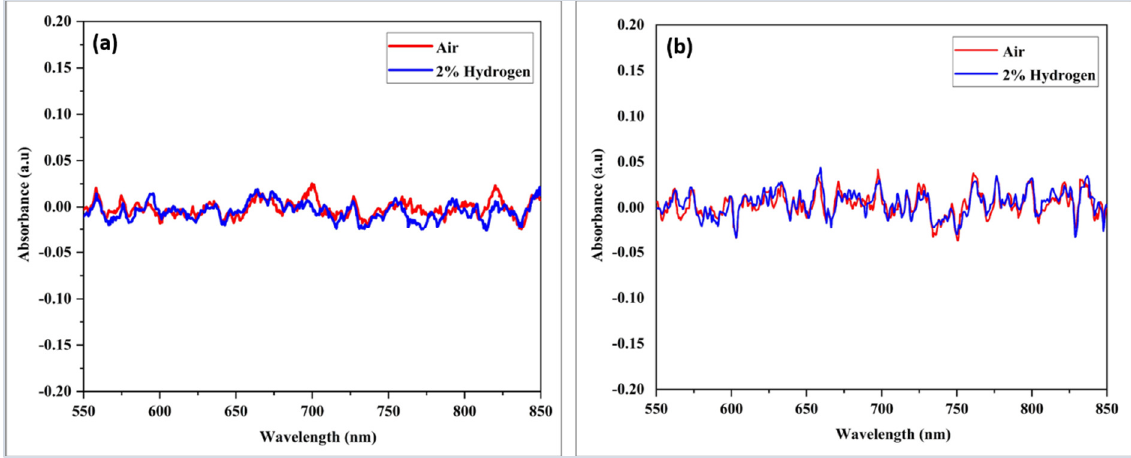
Figure 12. Absorbance response versus wavelength for multimode optical fibers ( a ) untampered and ( b ) tapered when exposed to 2.00% H 2 at room temperature.